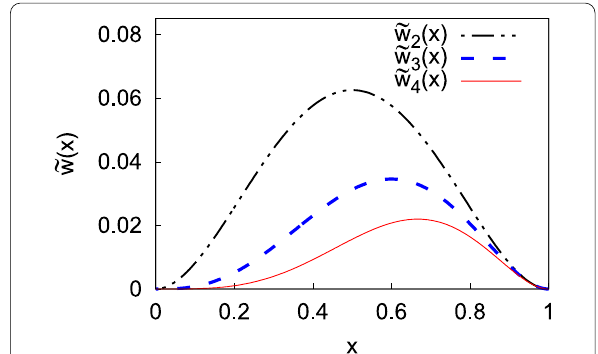
Fig. 5 Mode shapes for clamped–clamped